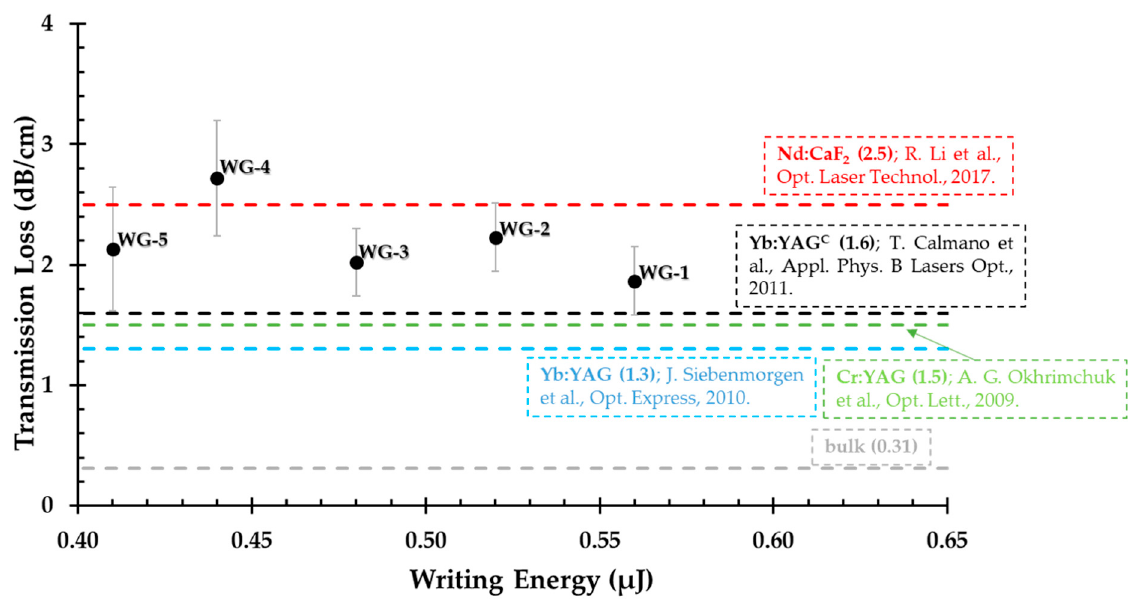
Figure 4. Transmission loss (dB / cm) of the CaF 2 undoped crystal double-track waveguides in comparison with some previously reported transmission losses where red is for a Nd:CaF 2 crystal [31]; black for a Yb:YAG ceramic [49]; green for a Cr:YAG crystal [17] and blue for a Yb:YAG crystal [11]. The gray line at 0.31 dB / cm is the transmission loss of the CaF 2 unmodified zone. The error bars in the measurements indicate the standard deviation of the data from multiple experimental runs.